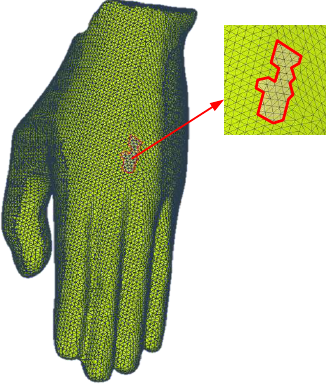
Figure 2. Hole detection results; the hole is marked by the red line.